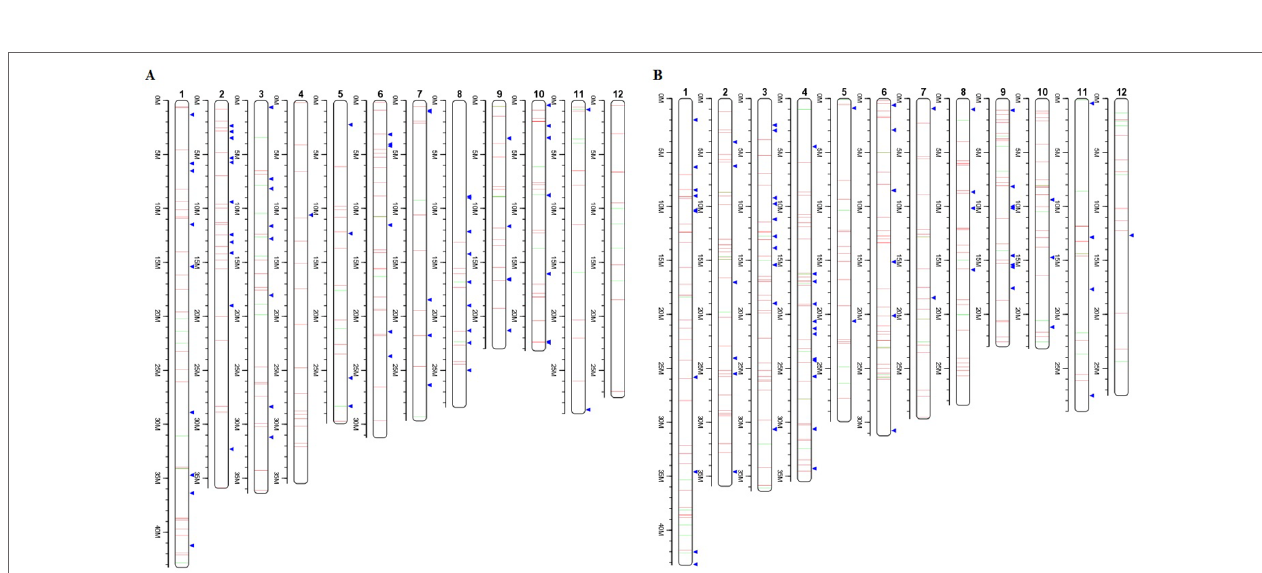
FIGURe 4 | Distributions of different mutation types on the each chromosome. (a) : Distribution of mutations from all the six CIB CIB-induced lines; (B) : Distribution of mutations from all the four GR-induced lines. Red lines represent SBSs, green lines represent MNVs, and blue triangles represent Indels.